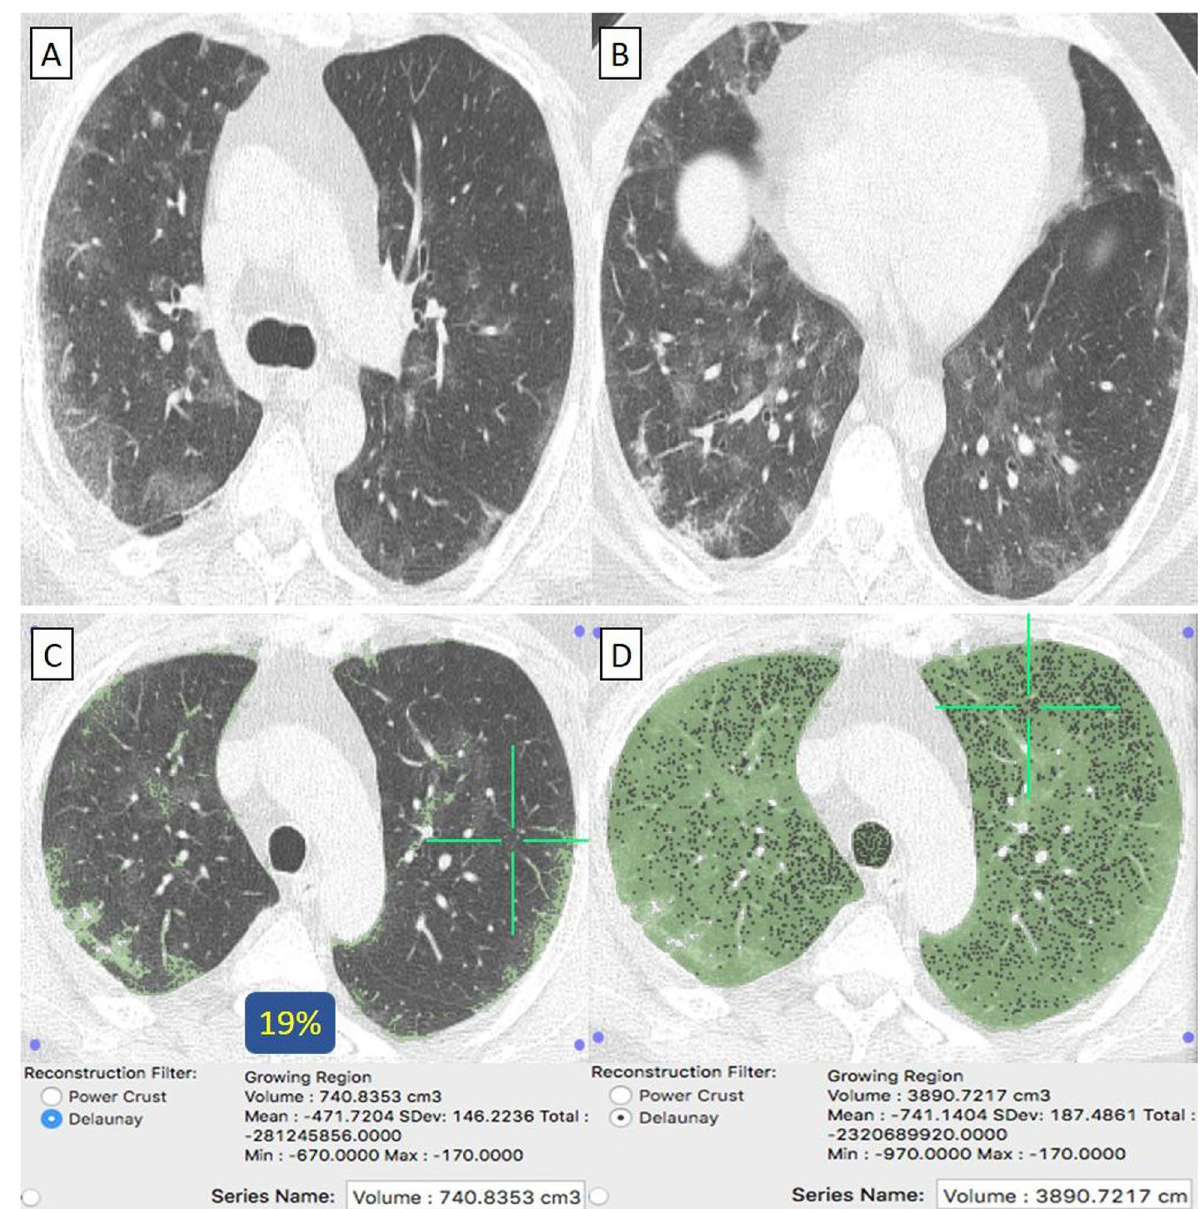
Fig. 2 A 58‑year‑old female patient with negative past medical history and had received “Sinopharm” vaccine then got COVID‑19 infection. A , B Axial chest CT cuts (lung window) showed bilateral mainly peripheral located ground‑glass pneumonic patches and minimal right pleural reaction. C CT‑Volumetry of the pathological lung parts averages 740 cc. D CT‑Volumetry of total lung volume averages 3890 cc. So, only 19% of the lung parenchyma was diseased (Score